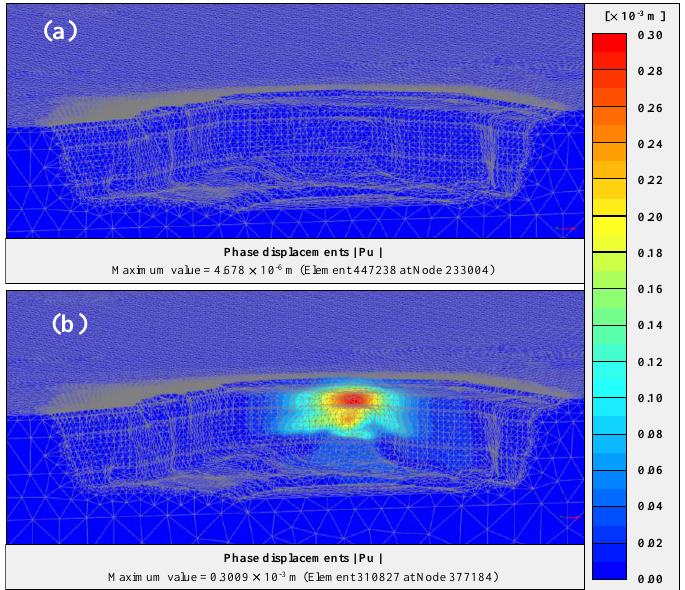
Figure 11. Displacements from plastic phases of analyses: ( a ) pre- and ( b ) post- rock block detachment.